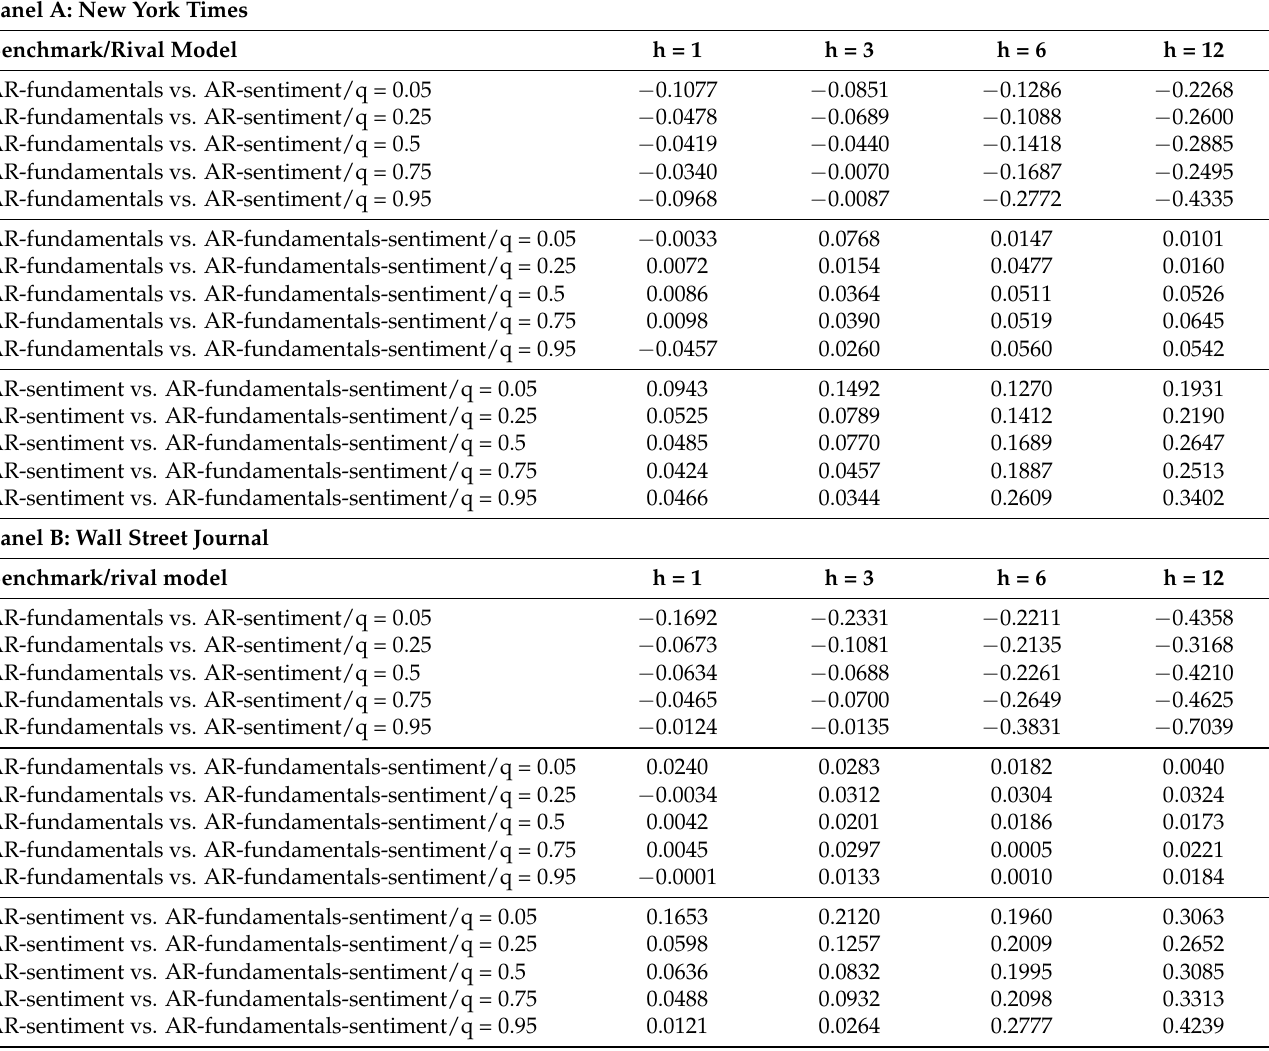
Table A4. Results for bad realized